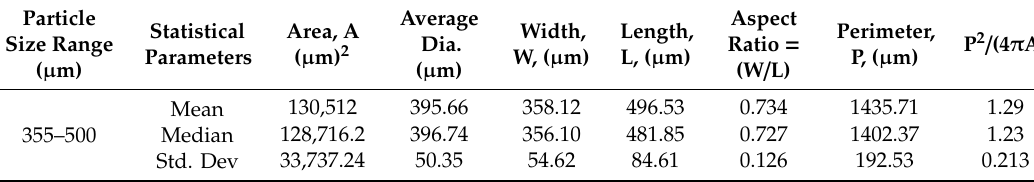
Figure 3. Scanning electron micrograph of SiO 2 silica sand erodent [51]. Table 3. Statistical values are determined from image analysis processing of particle